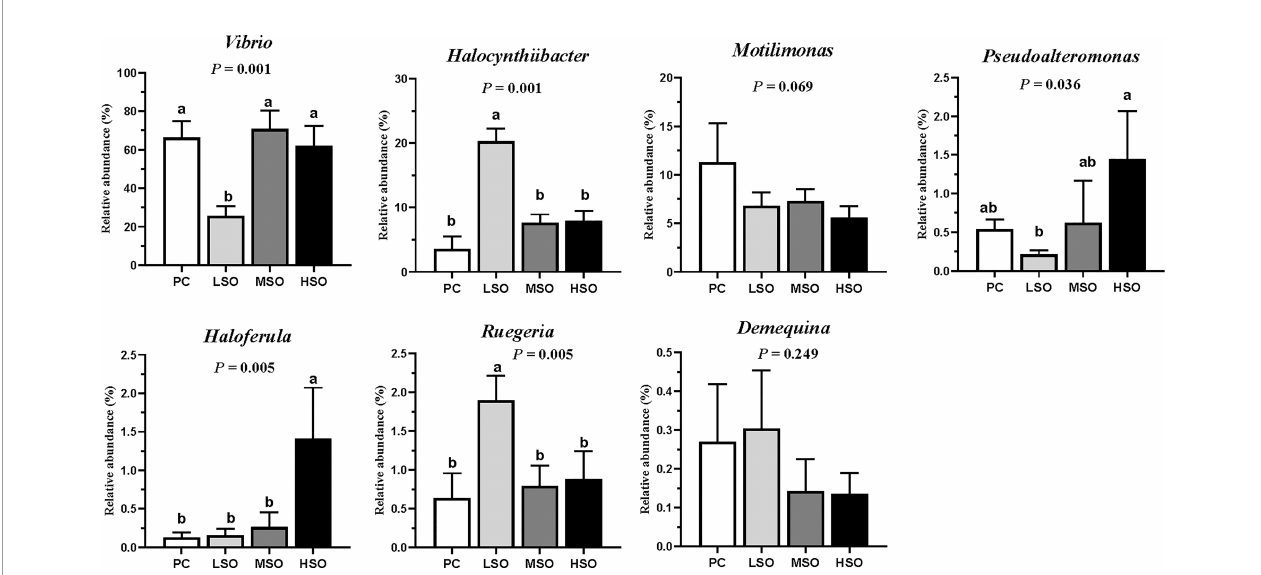
FIGURE 6 | Microbial relative abundance on the top 7 genus level of shrimp in this study. Vertical bars represent the mean ± SD ( n = 3). Data marked with different letters differ signi fi cantly ( p < 0.05) among groups based on Tukey ’ s multiple